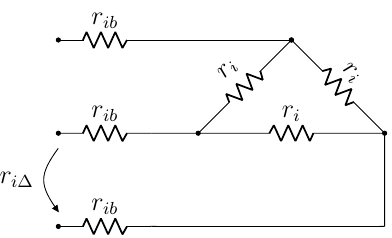
Figure 4. Proposed DC model for ∆